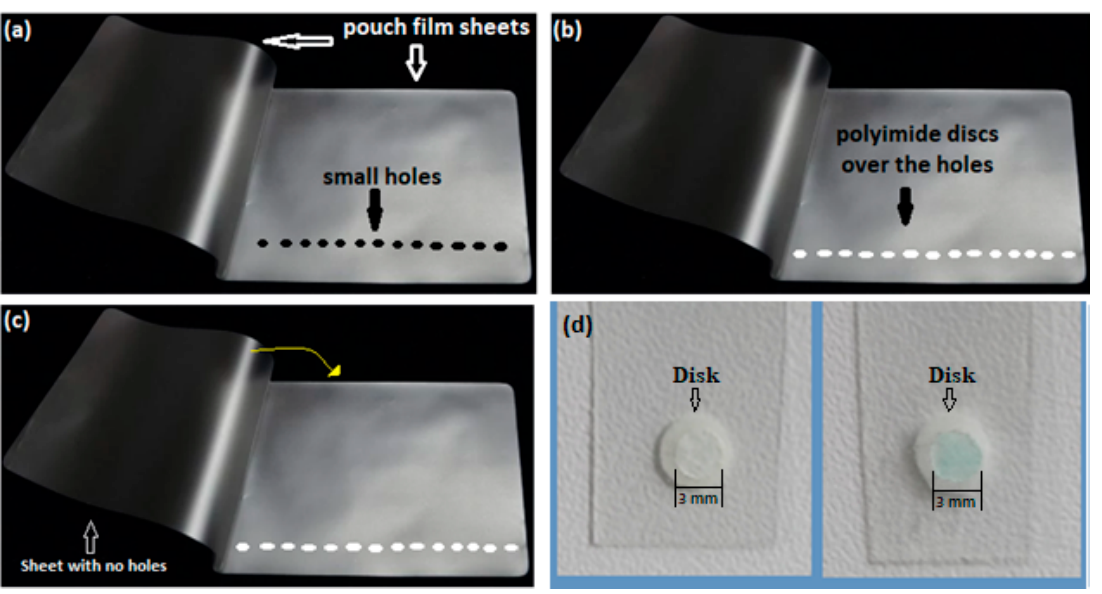
Figure 2. Propylene film sheet with small holes (3.0 mm diameter) ( a ). Sheet with polyimide disks put over the small holes ( b ). The second sheet with no holes is to be laid over the sheet containing the disks ( c ). Polyimide nanofiber disks are attached to the laminated sheets before MG adsorption (( d ) left) and after adsorption (( d ) right).